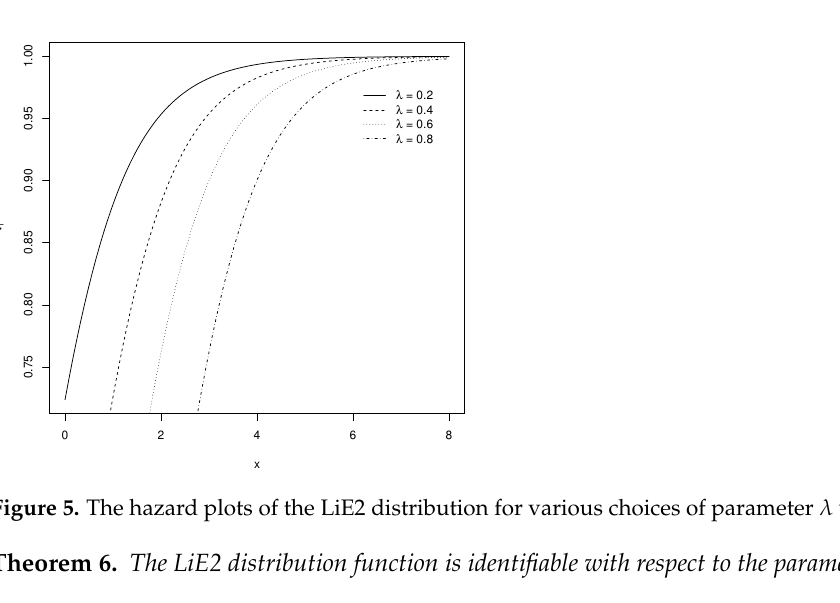
Figure 4. The plots of the density function of the LiE2 distribution for various choices of parameters with θ = 1 ( left ) and λ = 0.5 ( right ).